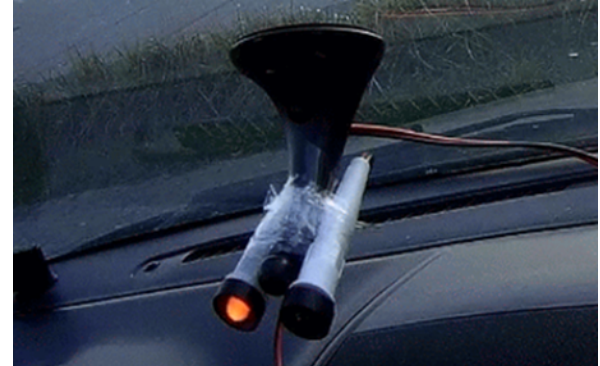
Figure 4: Light signal call control buttons [18].